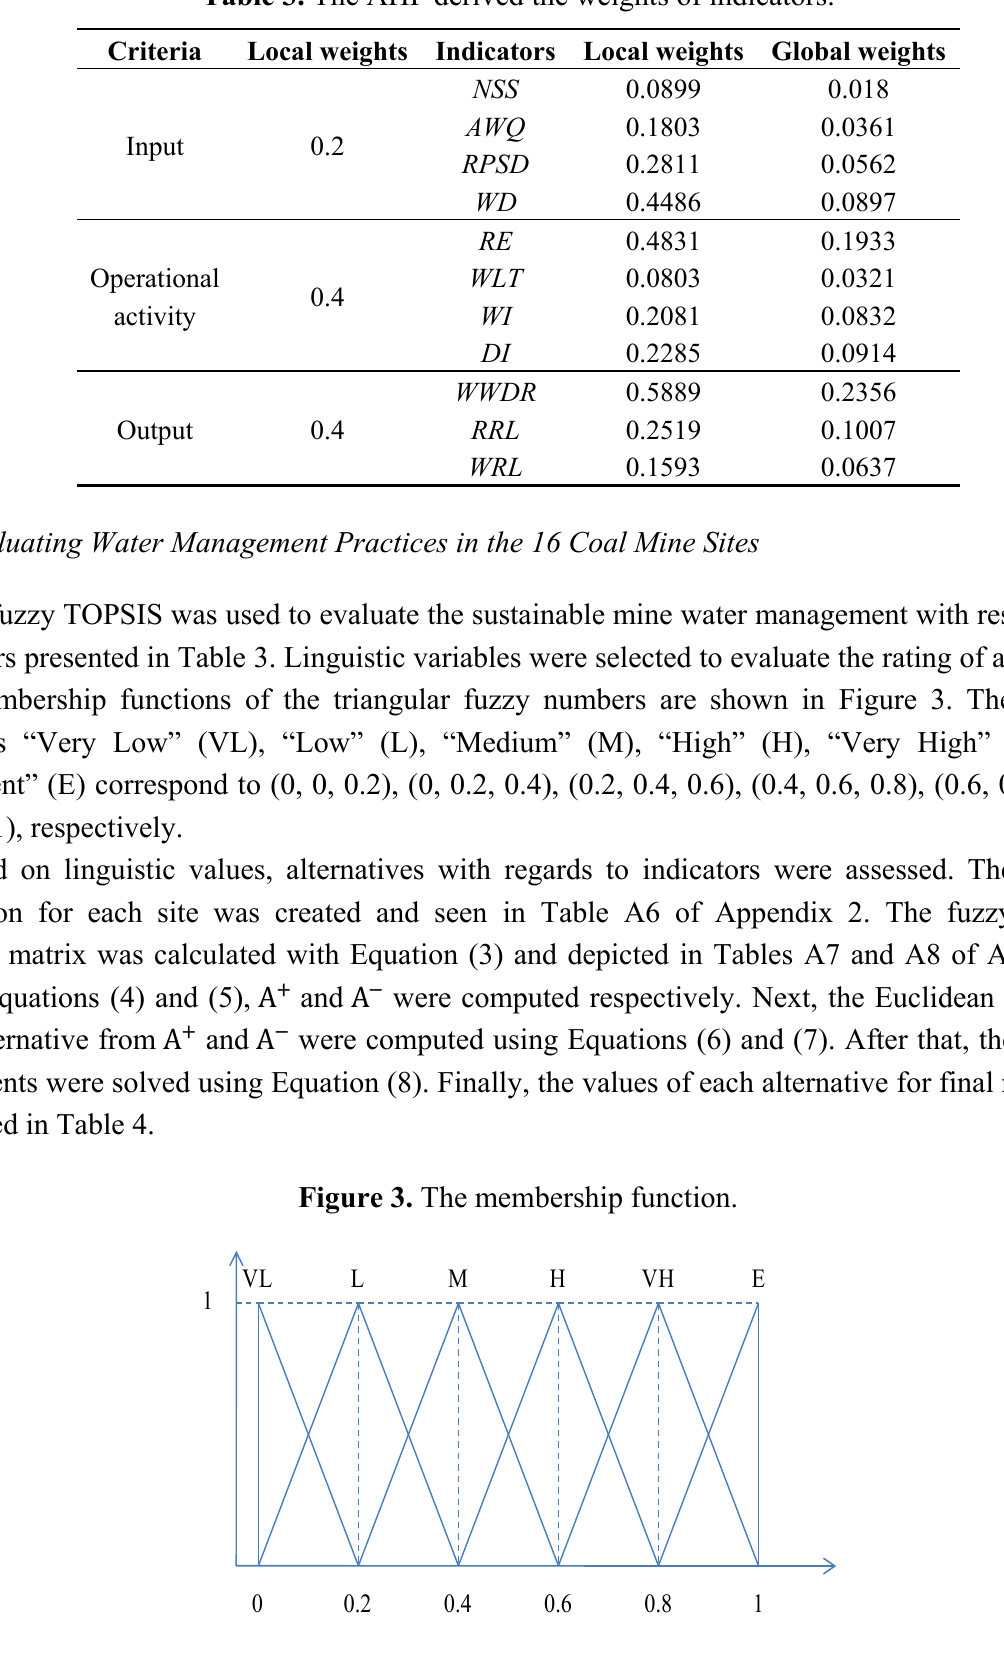
Table 3. The AHP derived the weights of indicators.